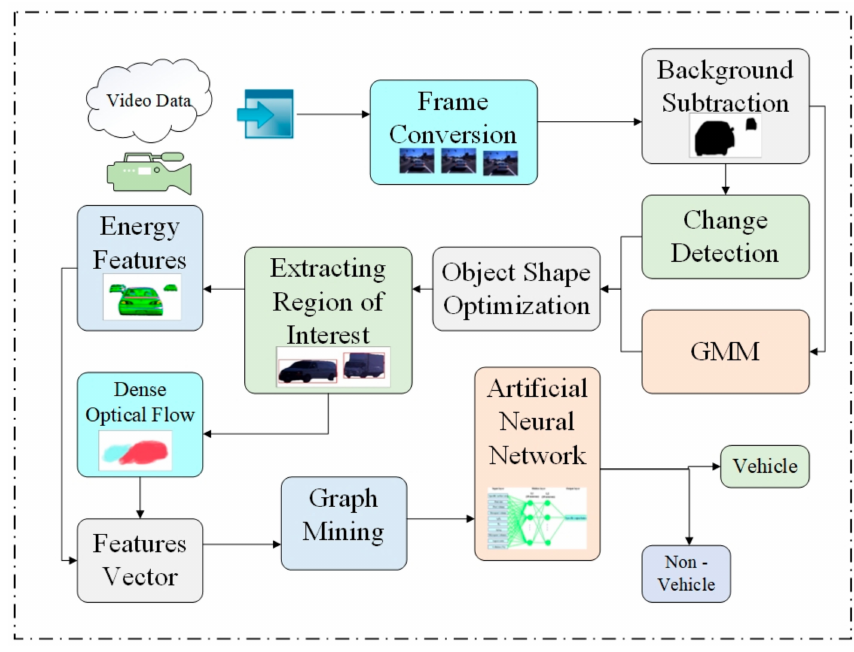
Figure 1. The suggested vehicle detection framework process diagram.